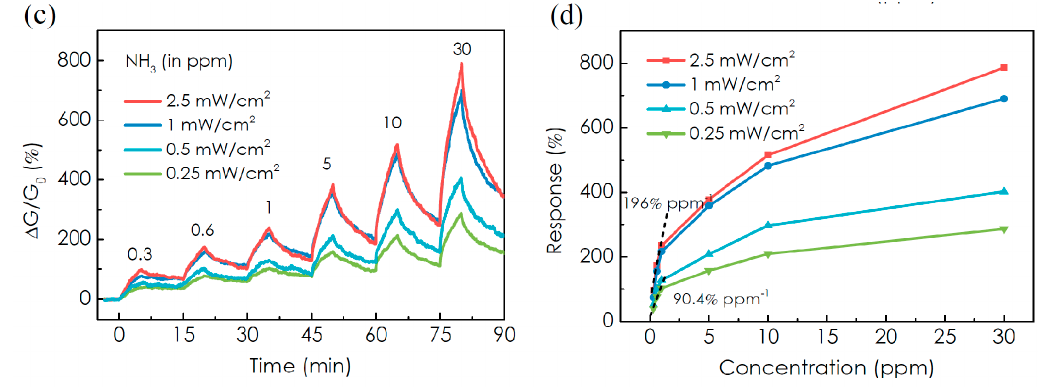
Figure 15. ( a ) Real-time conductance change of the MoTe 2 sensor upon exposure to different concentrations of NH 3 in the dark and under light illumination; ( b ) calculated response and calibration curves of the MoTe 2 sensor as a function of wavelength (photon energy); ( c ) real-time conductance change of the MoTe 2 sensor upon exposure under 254 nm UV light illumination; and ( d ) calculated response and calibration curves of the MoTe 2 sensor as a function of UV light intensity. Reprinted from [112], MDPI, Basel, Switzerland.